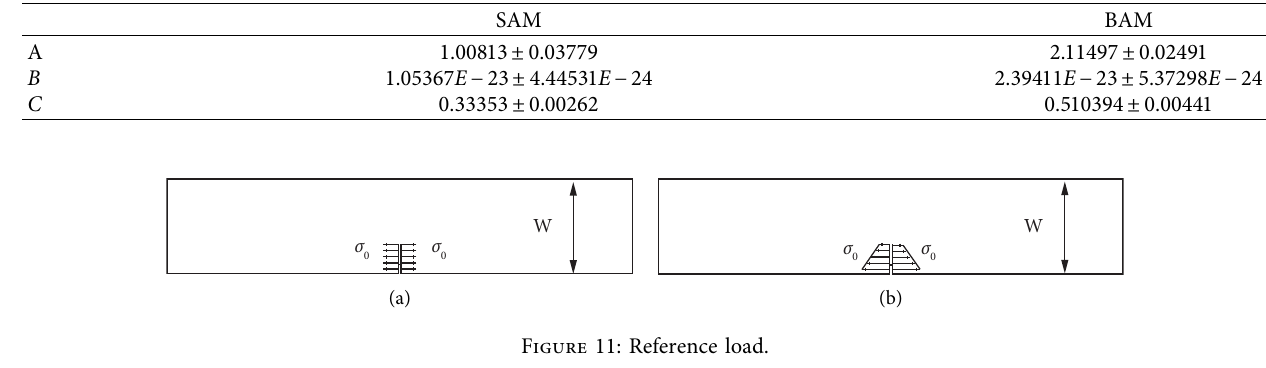
Table 8: Material parameters of SAM and BAM.